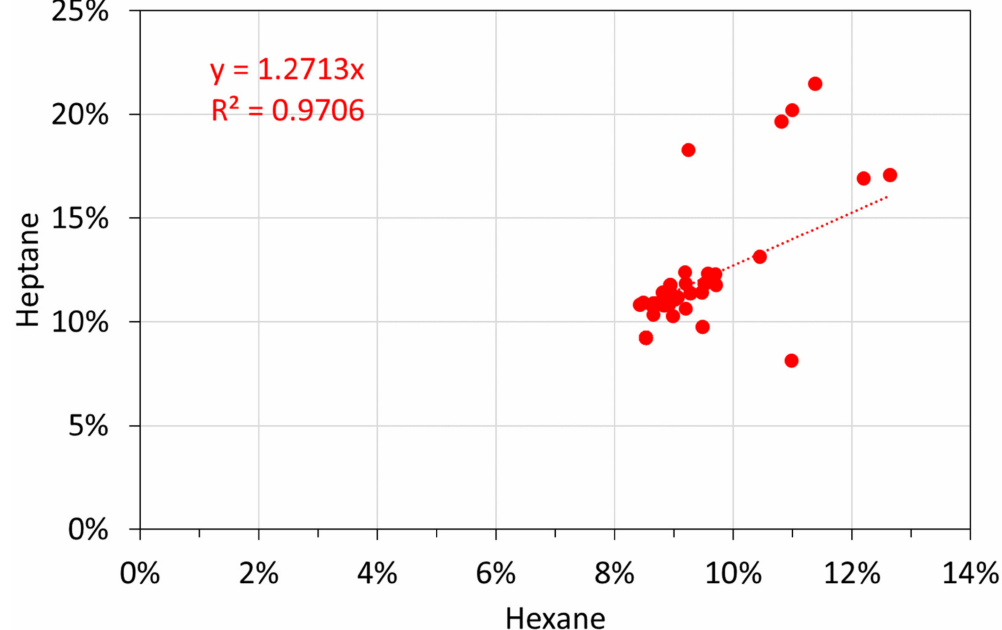
Figure A16. Molar alkane oil analyses: hexane vs.